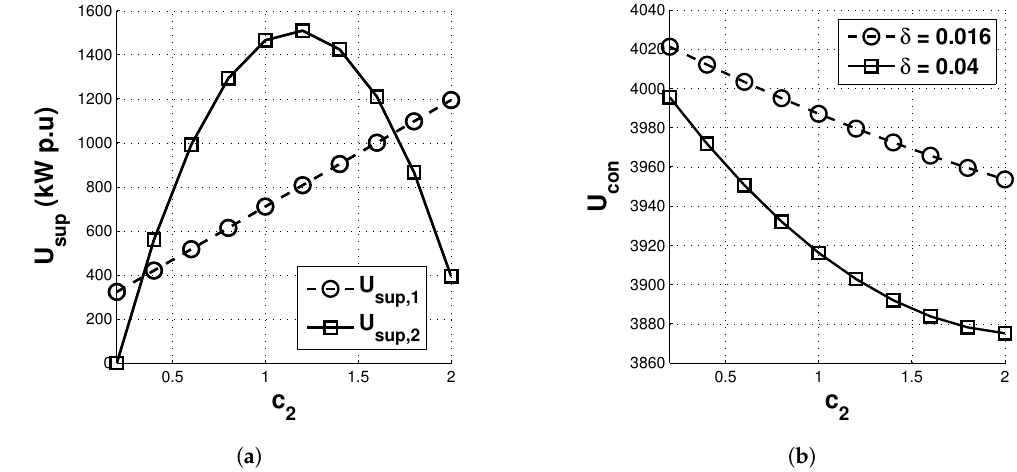
Figure 3. ( a ) Utility of supplier and ( b ) net utility of consumers ( δ = 0.016, 0.04) as the price offered by supplier 2 varies.